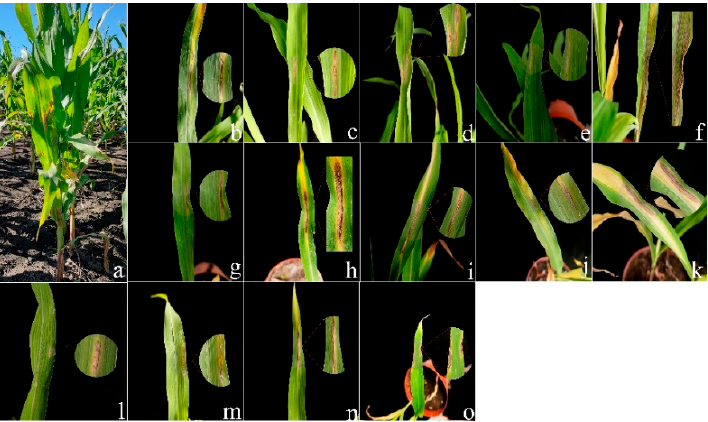
Figure 4 . ( a ) Leaf blight symptoms on maize leaves caused by Fusarium species in the field; ( b – o ) Typical symptoms observed in greenhouse on maize leaves after inoculation with: ( b ) F. ipomoeae ; ( c ) F. compactum ; ( d ) F. flagelliforme ; ( e ) F. asiaticum ; ( f ) F. armeniacum ; ( g ) F. citri ; ( h ) F. sporotrichioides ; ( i ) Fusarium sp.; ( j ) F. glycines ; ( k ) F. graminearum ; ( l ) F. annulatum ; ( m ) F. temperatum ; ( n ) F. verticillioides ; ( o ) F. acuminatum .